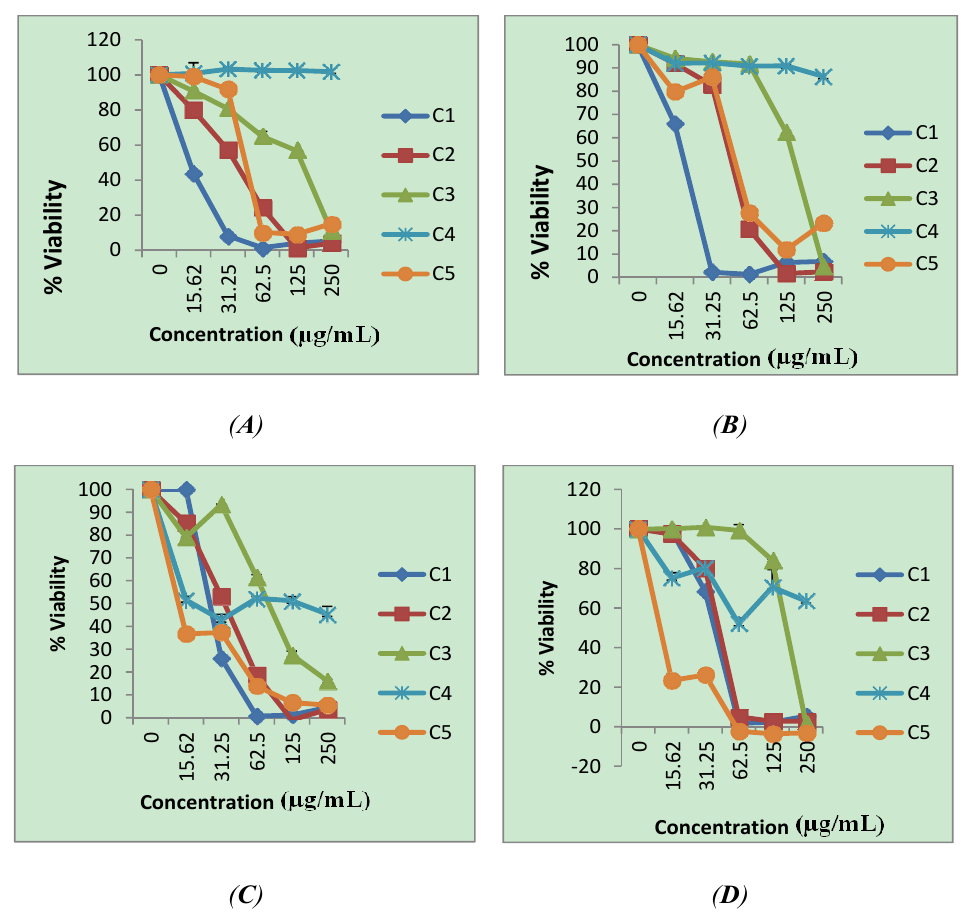
Figure 4. Effect of compounds 1 – 5 on cell viability of ( A ) HeLa cells ( B ) HT-29